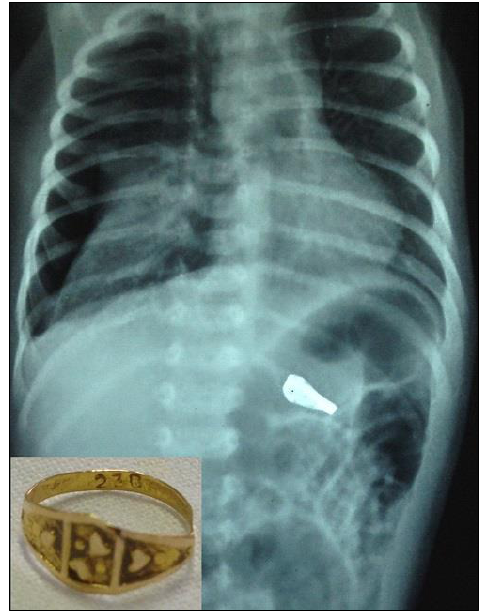
Figure1: Right side pneumothorax along with Radio-opaque foreign body in stomach. Inset shows retrieved